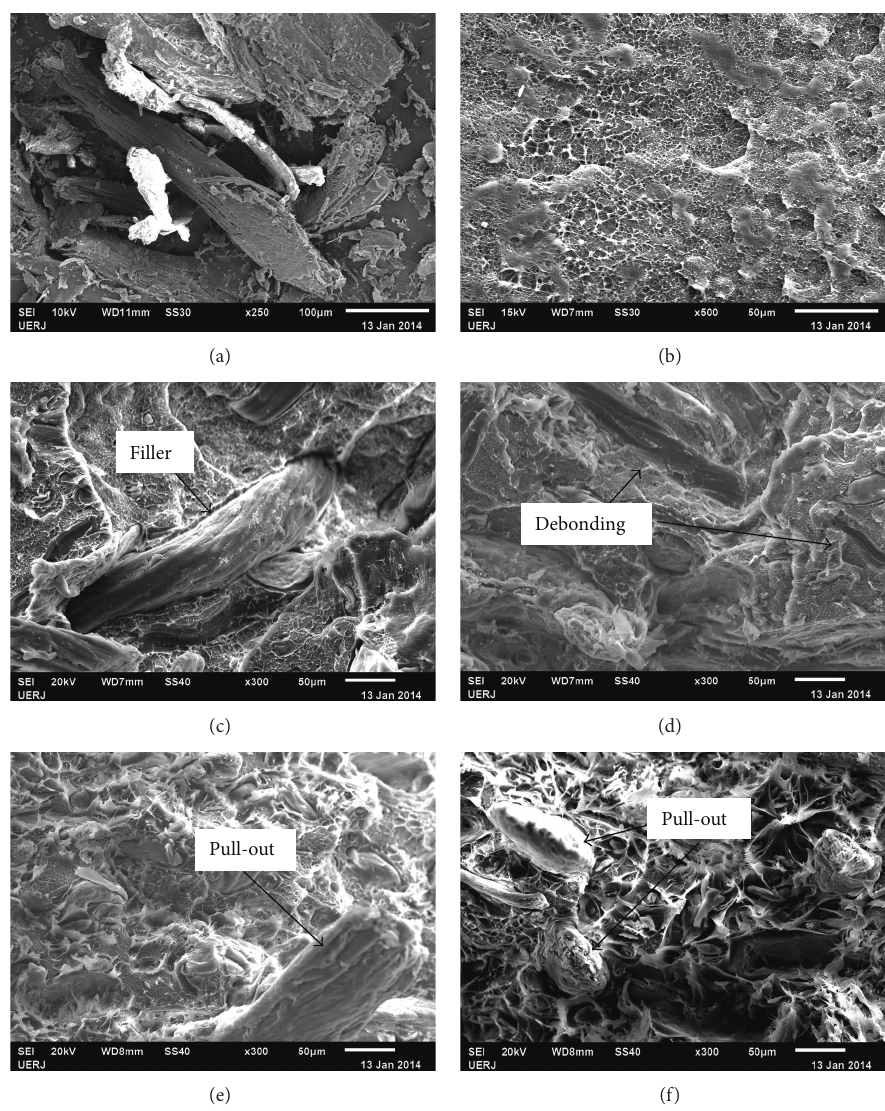
Figure 7: SEM micrographs of fracture surfaces for the following samples: sponge gourd residue with particle size < 0.15mm (a), renewable HDPE (b), and renewable HDPE/cellulosic filler composites: (c) 90/10%wt/wt, (d) 80/20%wt/wt, (e) 70/30%wt/wt, and (f)